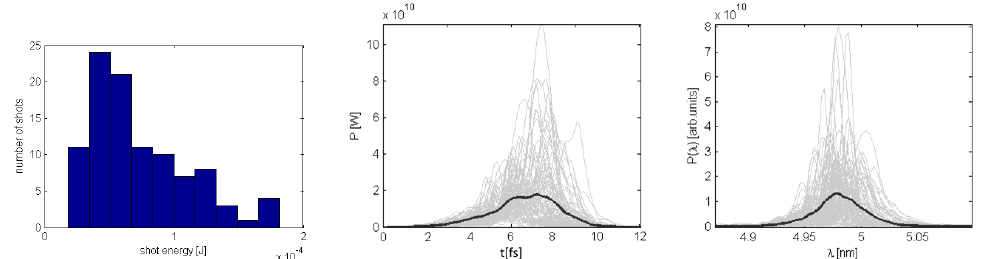
Figure 7. Radiation properties from U2 tuned at the fundamental photon energy of 250 eV. Notation the same as on Figure 6. The mean energy per pulse is 70 µ J (1.7 × 10 12 photons) and the mean pulse duration is about 3.3 fs FWHM.